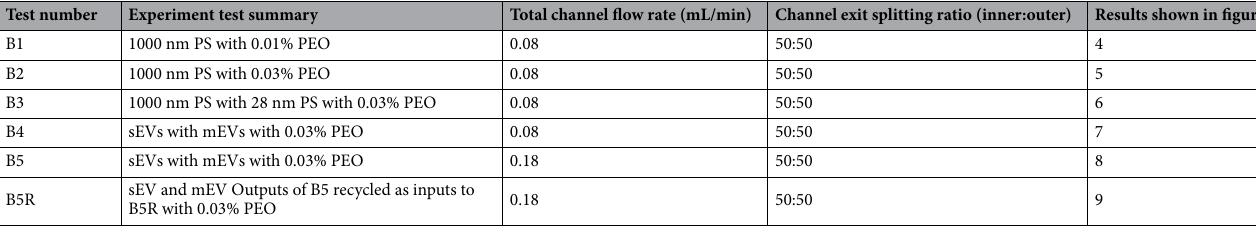
Table 2. Table of tests.